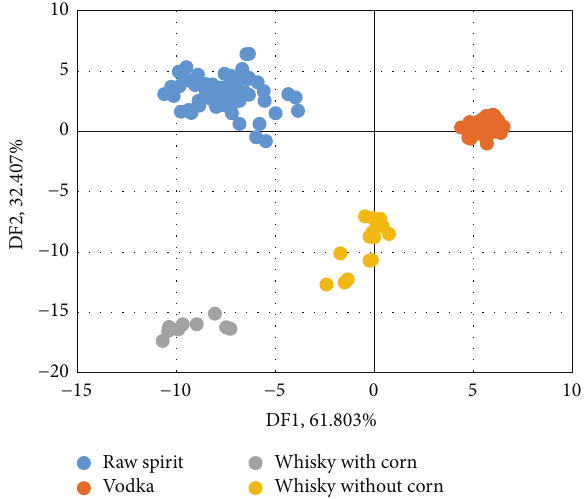
Figure 4: DFA results for vodkas, whiskies made from corn, whisky made without corn, and raw